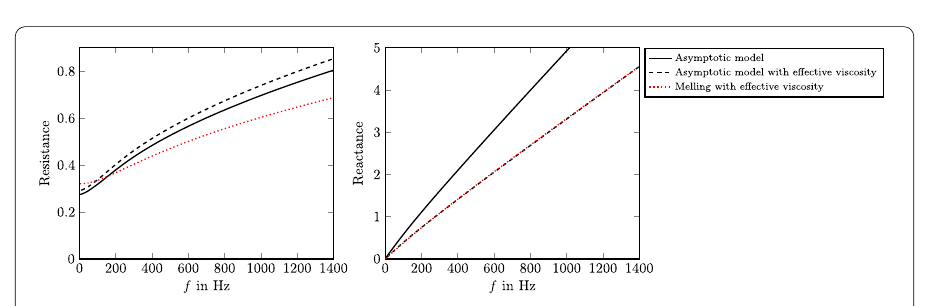
Figure 7 Comparison of the impedance with the normalized specific resistance ( left ) and the normalized specific reactance ( right ) computed by our model and Melling model as function of the frequency f = ω the liner configuration DC006. As Melling model uses an effective viscosity taking into account thermal conductivity losses we show the impedance for our model with the effective viscosity as